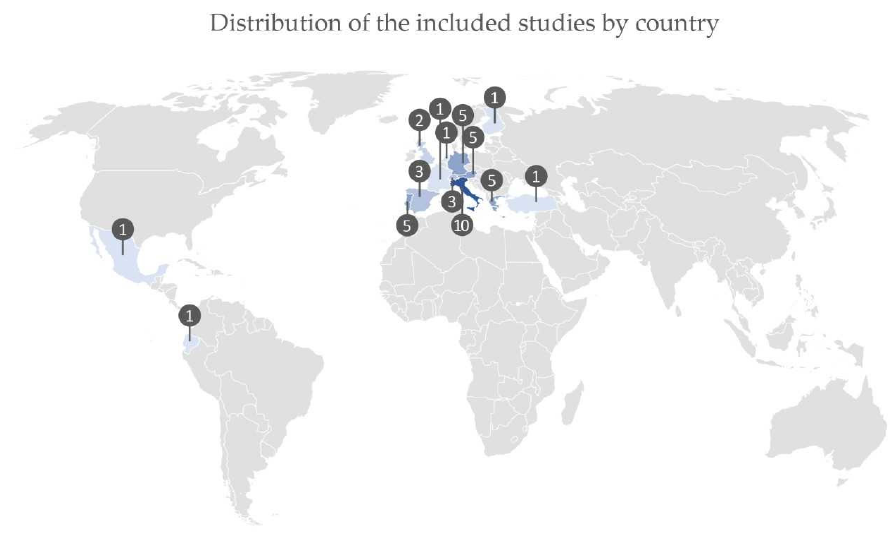
Figure 3. Distribution of the selected studies by country. Table 1. Multinational teams.